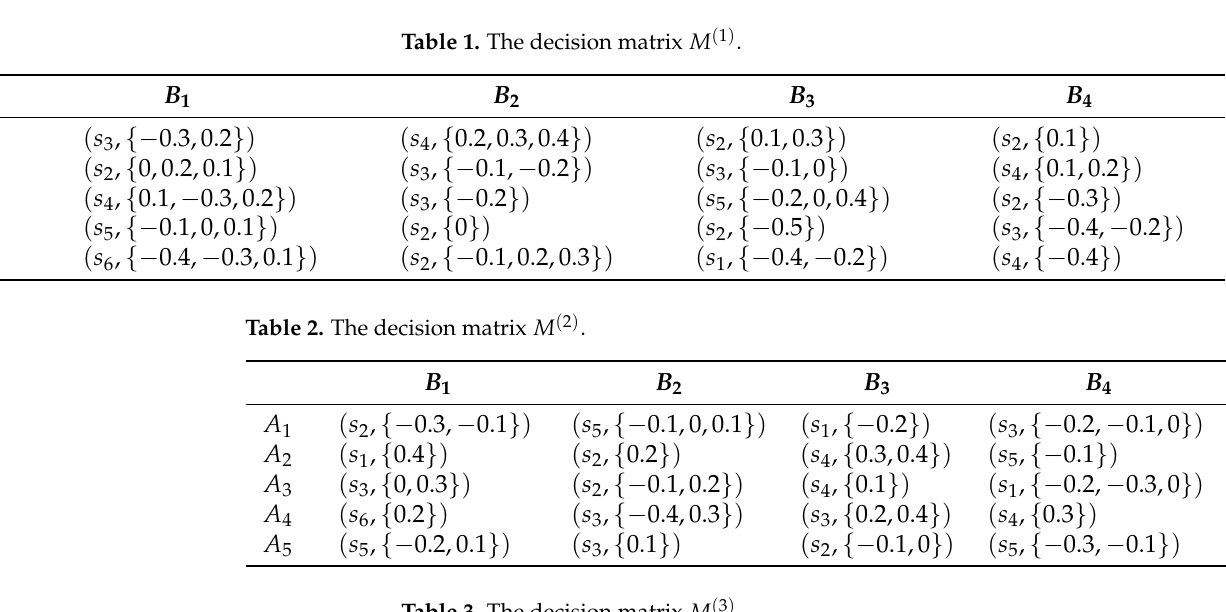
Table 3. The decision matrix M ( 3 ) .